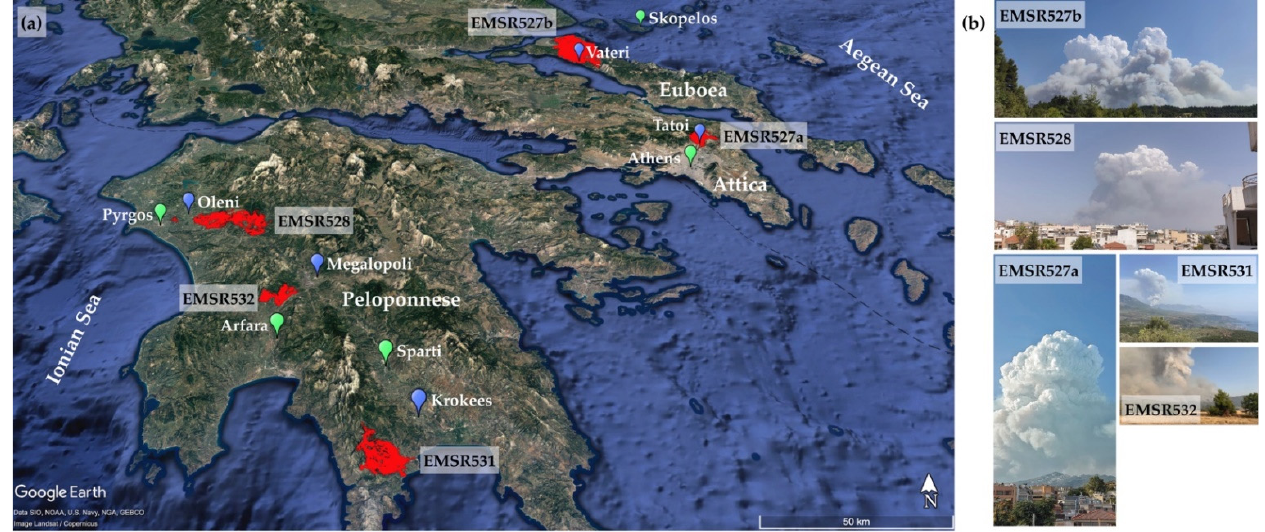
Figure 1. ( a ) Locations of the examined wildfires (Table 1) in the study area. Red shades denote the burnt areas according to the Copernicus Emergency Management Service. Blue and green balloons point to the locations of the surface weather stations used in this analysis (Table 2). ( b ) Photographic evidence of pyroconvection and extreme fire behavior (Photographs of Niki Glynou [EMSR527a], Elliot Kefalas [EMSR527b], Thodoris Kondylis [EMSR528], Ertnews.gr [EMSR531], and Messenialive.gr [EMSR532]).